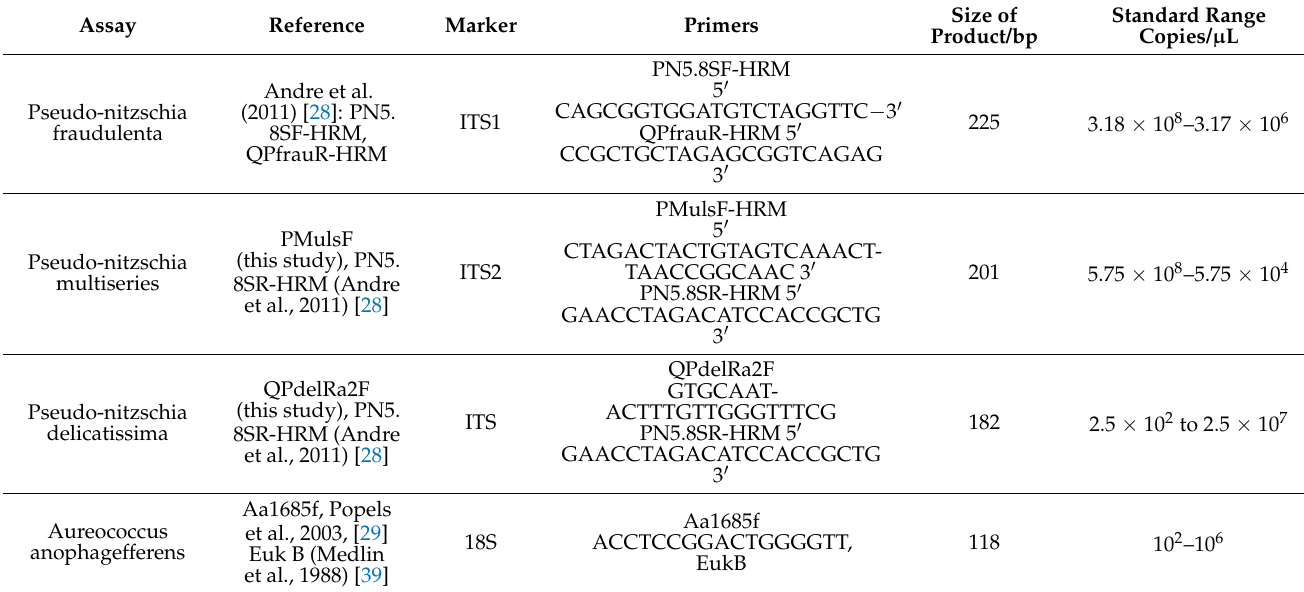
Table 1. qRT-PCR assays developed, species, primers, years